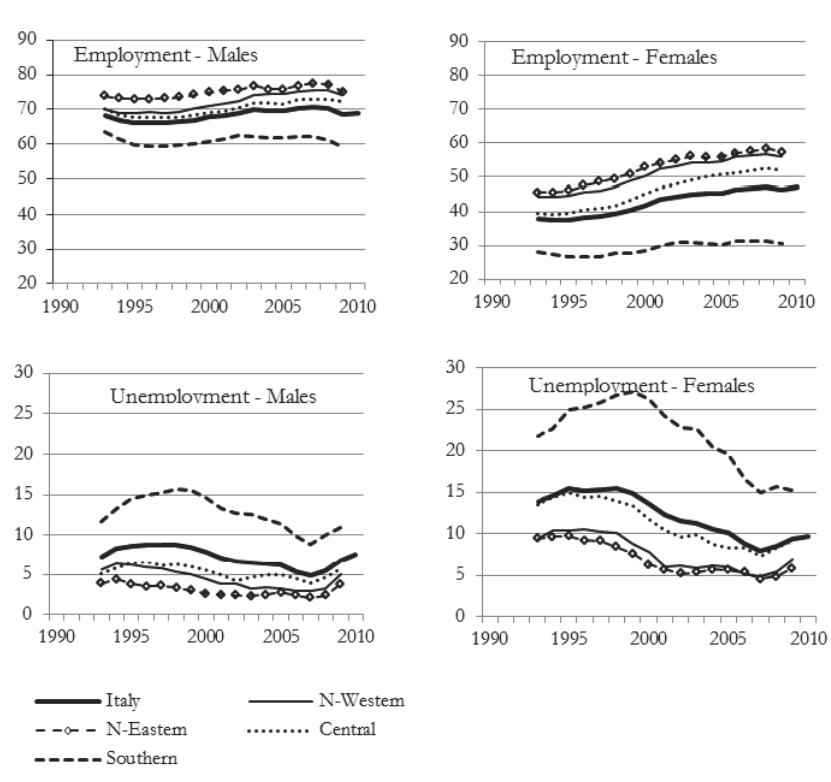
Figure 2 – Male/female employment 3 and unemployment 4 rates in Italian regions,